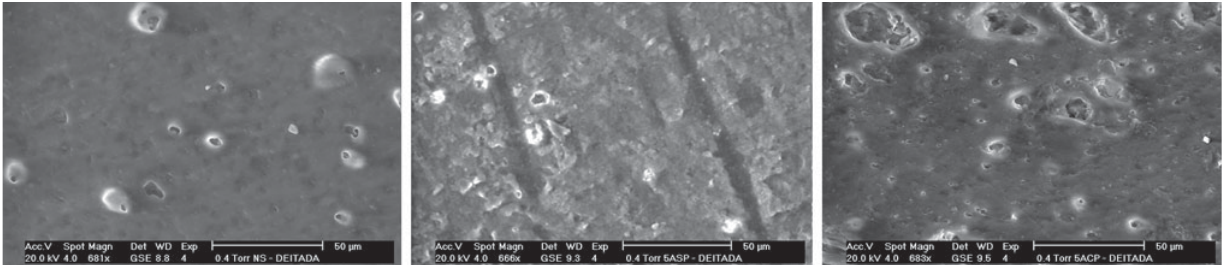
Figure 3 . SEM micrograph of the internal surfaces of the samples for (a) NS; (b) 5YWP; (c)